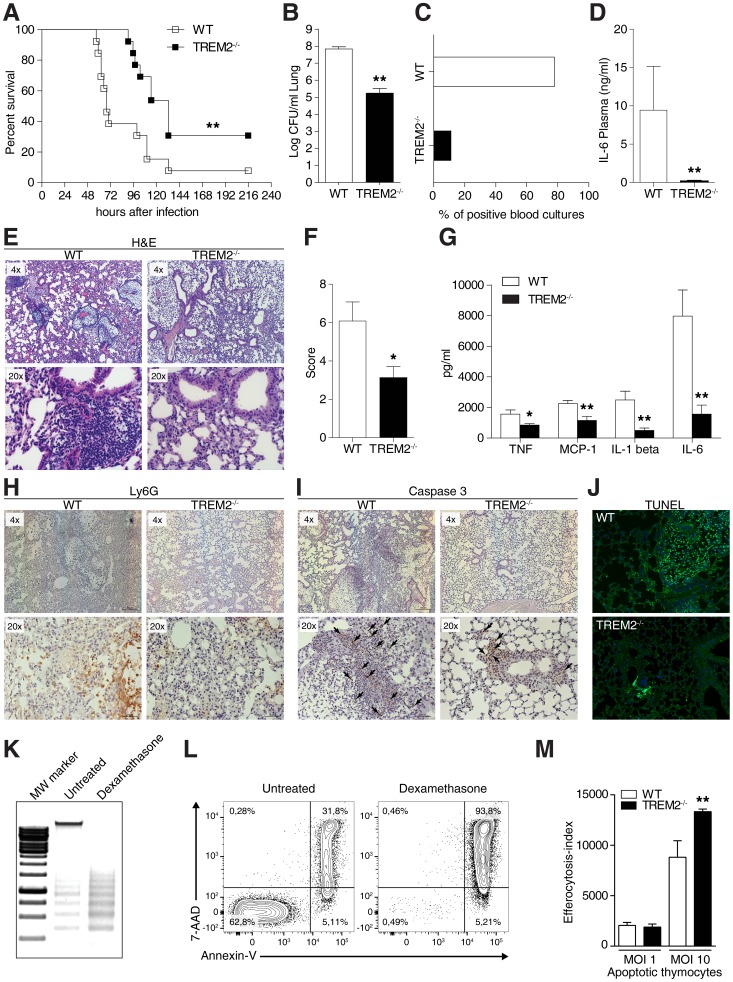
TREM-2 deficiency improves outcome during pneumococcal pneumonia.(A) WT and Trem-2
−/− mice were intranasally infected with 105 CFU S. pneumoniae and survival was monitored for 10 days (n = 13/genotype). (B–G) WT and Trem-2
−/− mice (n = 9 mice per genotype) were intranasally infected with 1×105 CFU S. pneumoniae and (B) lung bacterial CFUs were enumerated 48 h post infection. (C) Blood cultures were monitored for S. pneumoniae (D), IL-6 levels were evaluated in the plasma using ELISA. (E) Representative H/E staining of lungs 48 h post infection. (F) Lung inflammation score, as described in the Methods section. (G) Levels of lung cytokines were evaluated using ELISA. (H–J) Representative Ly6G (H), active caspase 3 (I) and TUNEL (J) staining of lungs 48 h post infection. Magnification depicted for TUNEL stains is 20× and arrows indicate caspase 3 positive cells. (K–L) Thymocytes (n = 4) were treated with 1 µM dexamethasone and apoptosis was evaluated using DNA laddering (K) or Annexin-V/7-AAD positivity (L). (M) WT and Trem-2
−/− AM (n = 8 per genotype and condition), were fed CFSE labeled apoptotic cells and efferocytosis was assessed 1 h later using FACS. Data in B, D, F, G and M are presented as mean ± SEM, WT versus TREM-2−/−. Data in A–G are representative of two independent experiments. Data in M is pooled data from 2 independent experiments; * p = <0.05, ** p = 0.005.